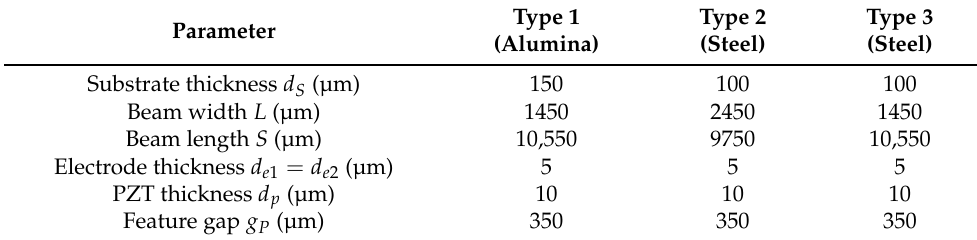
Table 1. Table of design parameters of the 4th generation devices.